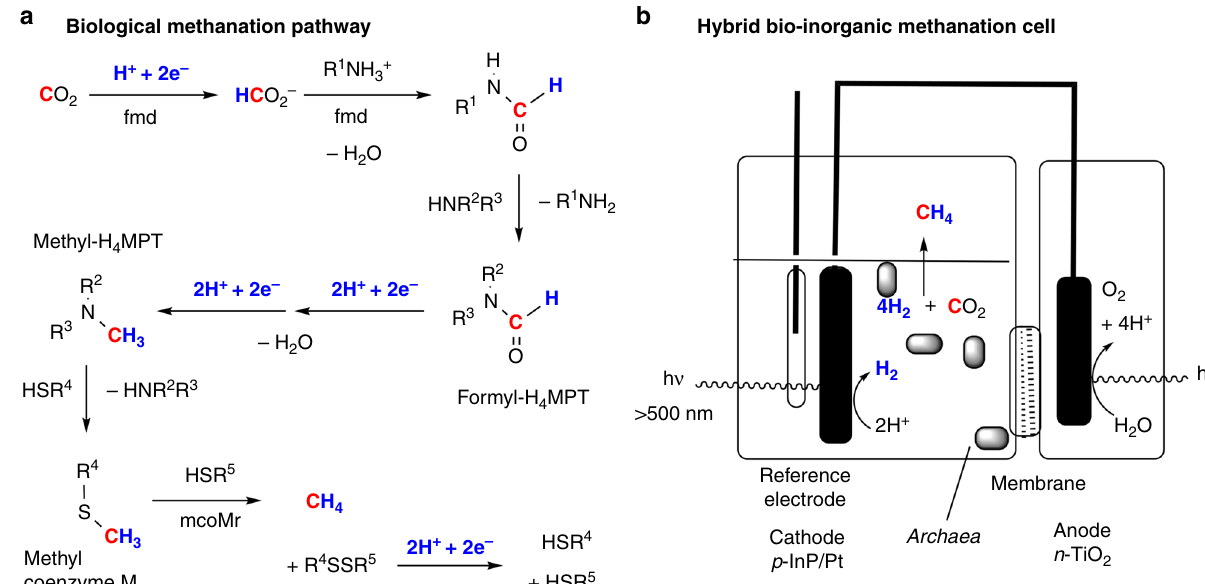
Fig. 4 Biomethanation reaction systems. a A simpli fi ed scheme describing the methanation of CO 2 catalyzed by archaea. Reproduced from ref. 97 (Copyright [2002], Elsevier) 97 . b A hybrid system for photomethanation utilizing CO 2 -metabolizing archaea in the cathode compartment as adapted with permission from ref.